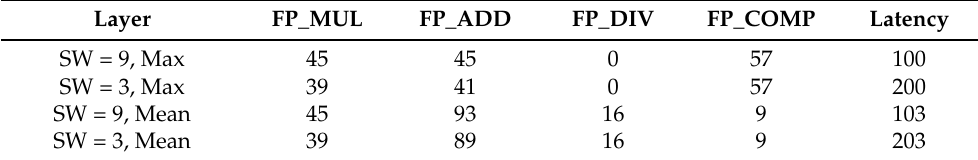
Table 1. Static analysis of different design